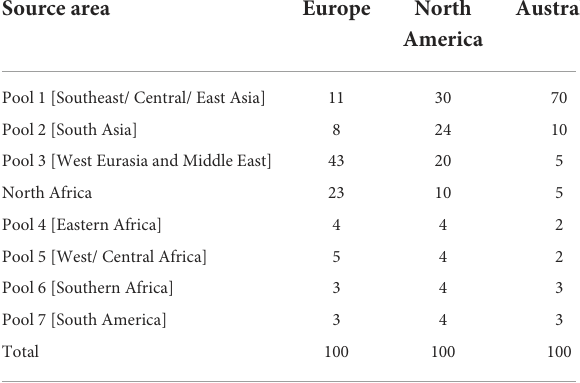
TABLE 1 Source area scores obtained through expert elicitation for each region. Source